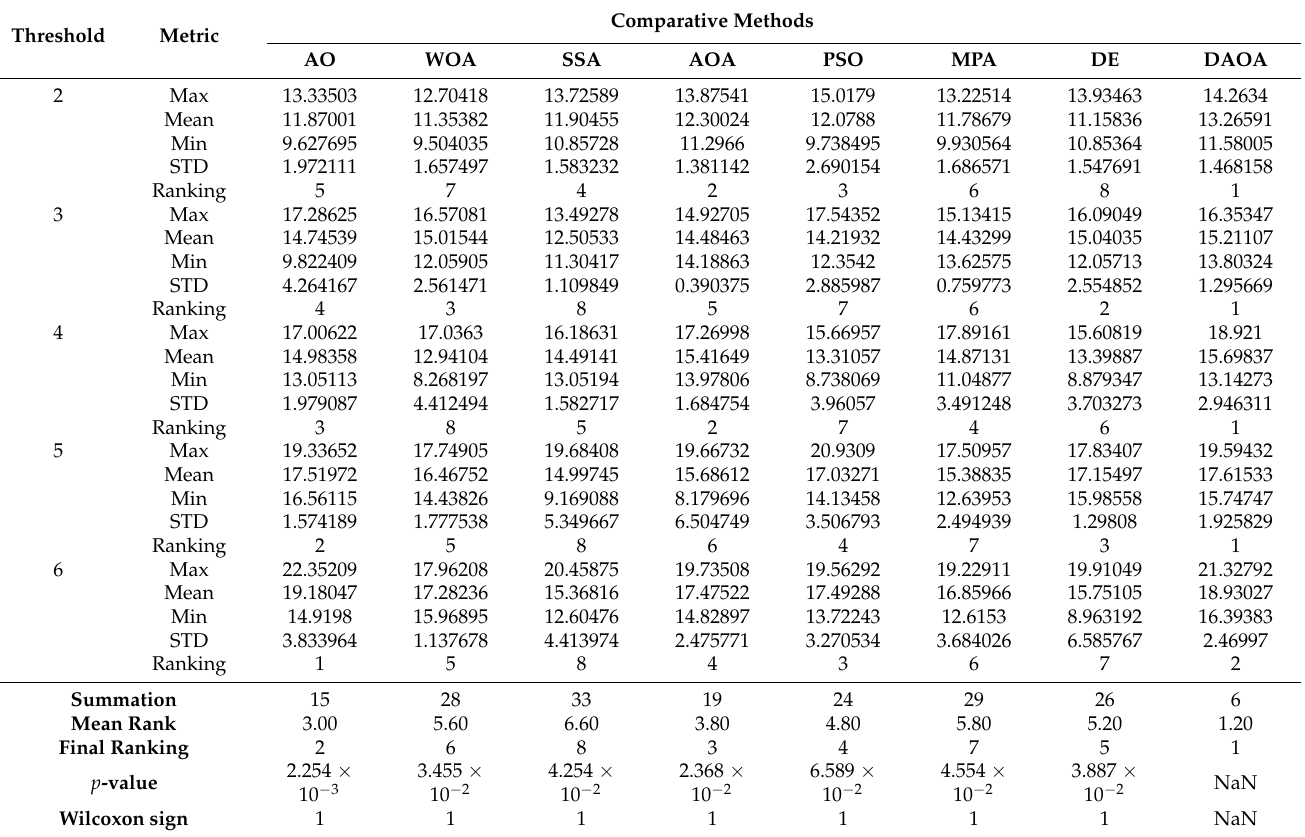
Table 16. The PSNR results of the test case